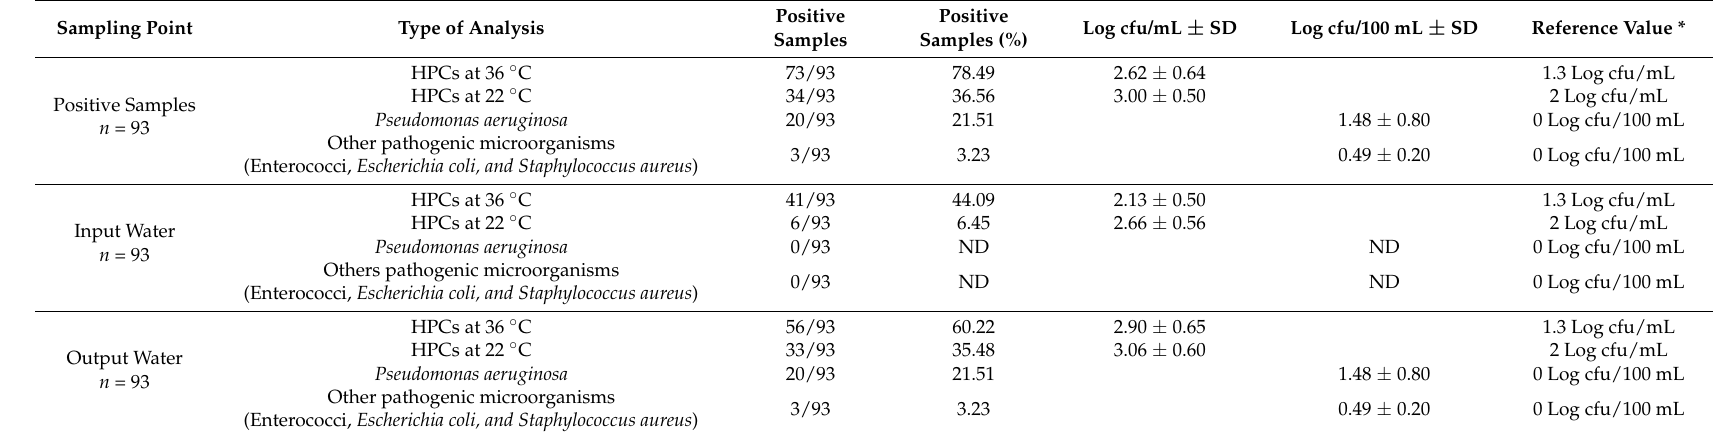
Table 1. Contamination of total of samples of MWDs (microfiltered water dispensers, n = 46) and contamination at the sampling point (input and output): HPCs (heterotrophic plate counts) at 36 ◦ C, HPCs at 22 ◦ C, Pseudomonas aeruginosa and other pathogenic microorganisms (Enterococci, Escherichia coli , and Staphylococcus aureus